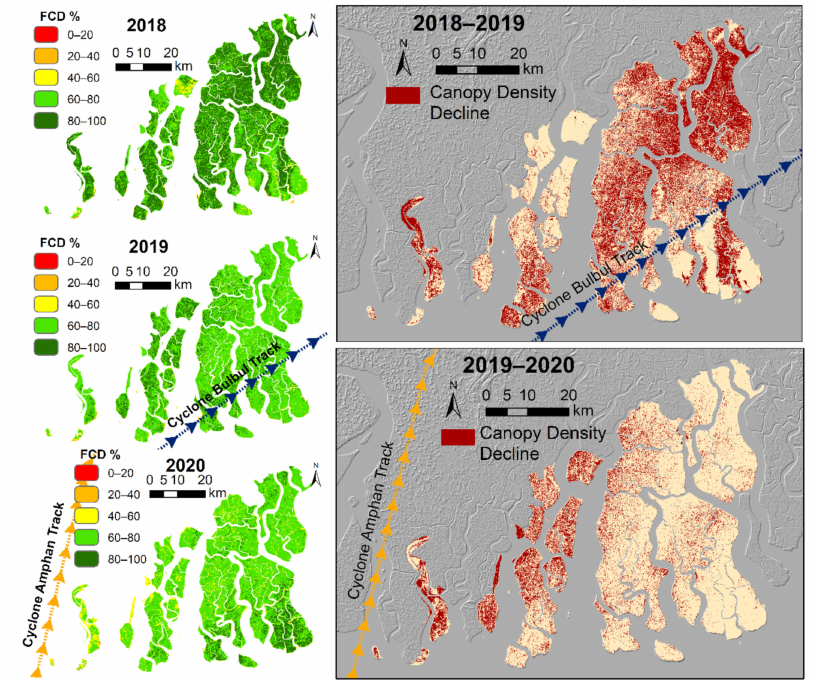
Figure 10. Change in the forest canopy density (FCD) of the mangroves after cyclones Bulbul (2019) and Amphan